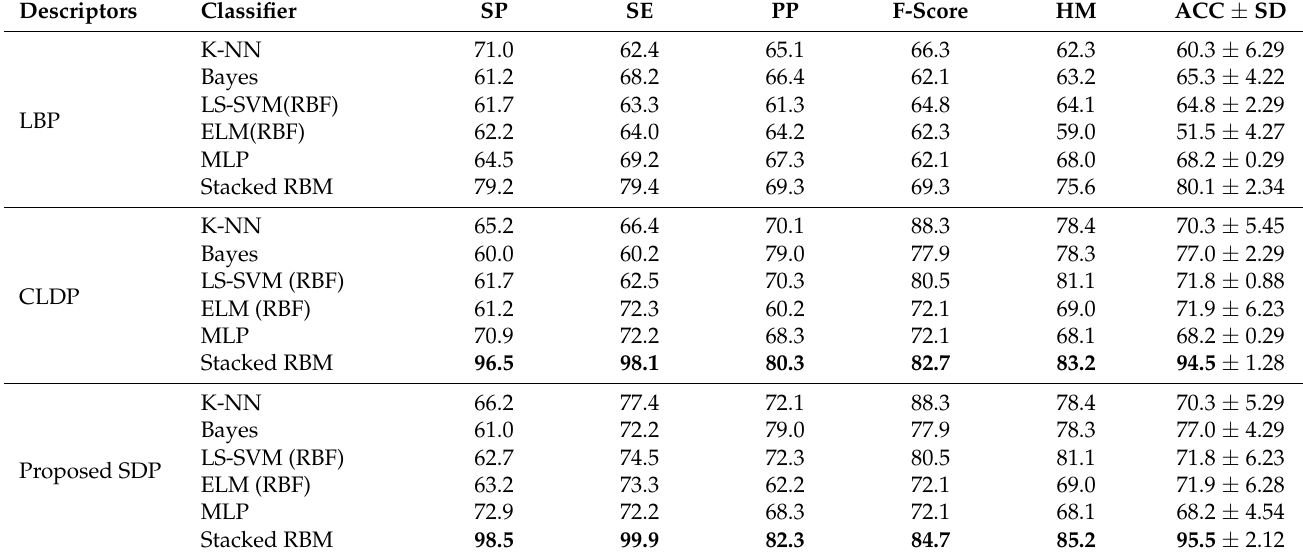
Table 7. Classification outcomes of pictures from ISIC